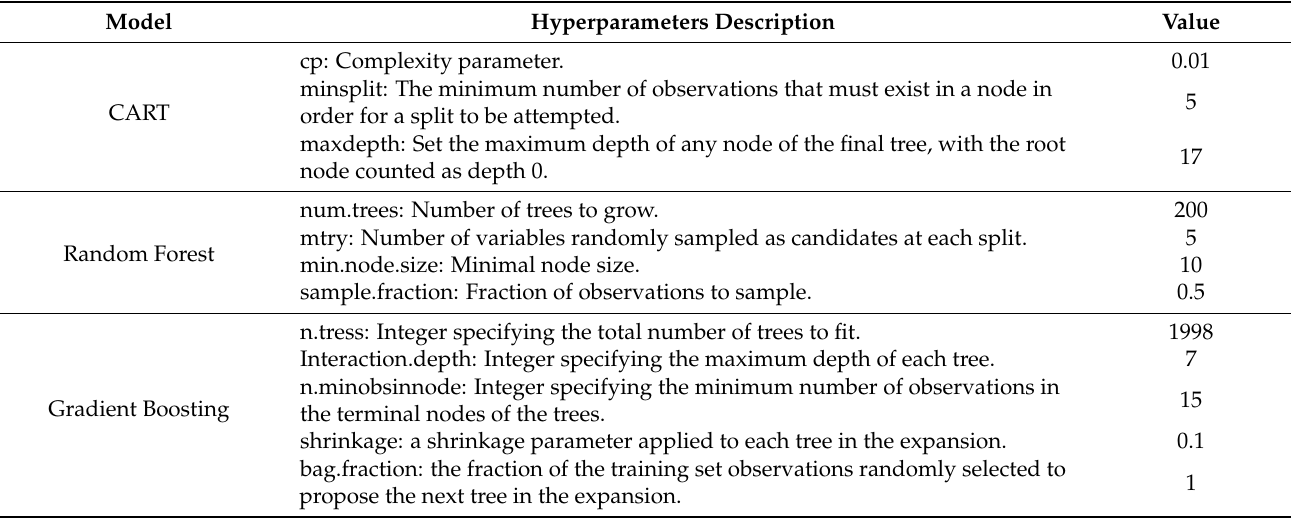
Table 4. Hyperparameters used in the execution of the